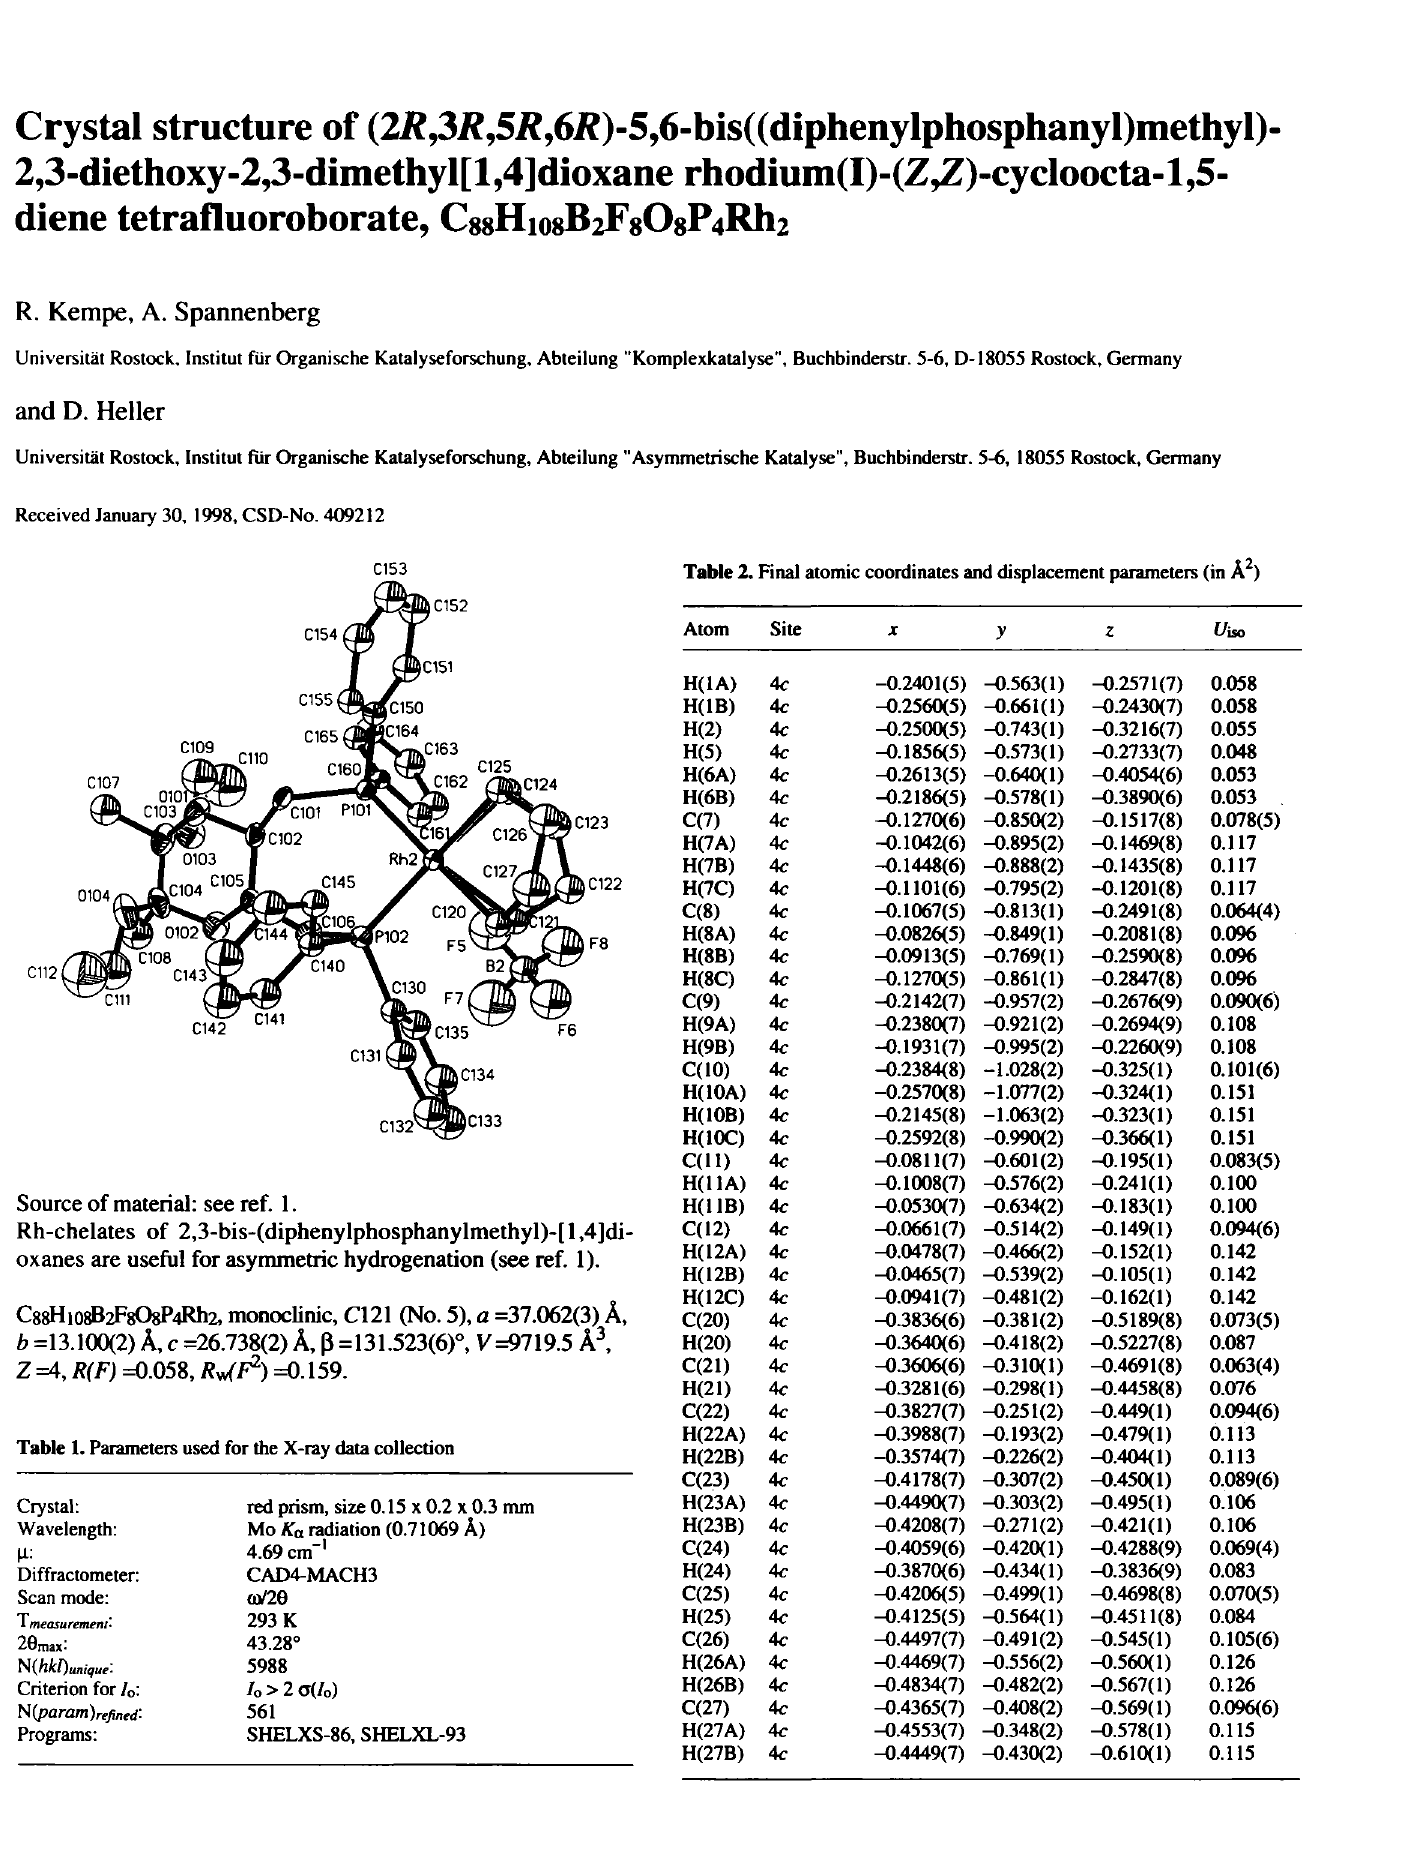
Table 1. Parameters used for the X-ray data collection Crystal;